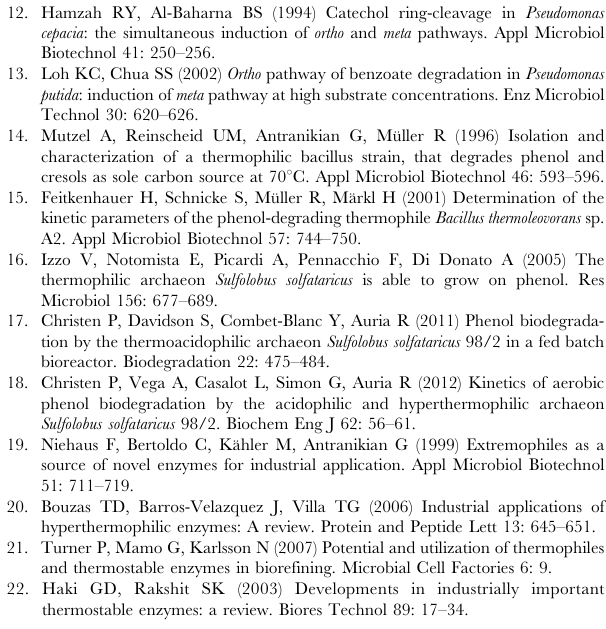
Figure S1 Phenol degradative pathways. Dot arrow, ortho pathway. Dash arrow, meta pathway. MO, monooxygenase; C12D, catechol 1,2 dioxygenase; C23D, catechol 2,3 dioxygenase; 2-HMS H, 2-HMS hydrolase, 2-HMS DH, 2-HMS dehydroge- nase; 4OT, 4-OC tautomerase; 4OD, 4-OC decarboxylase; OE H, OE hydratase; 2-HMS, 2-hydroxymuconic semialdehyde; 2- HMA, 2-hydroxymuconic acid; 4-OC, 4-oxalocrotonate; OE, 2- oxopent-4-dienoate; HOV, 4-hydroxy-2-oxovalerate; TCA: Tri- carboxylic acid (adapted from Omokoko et al.